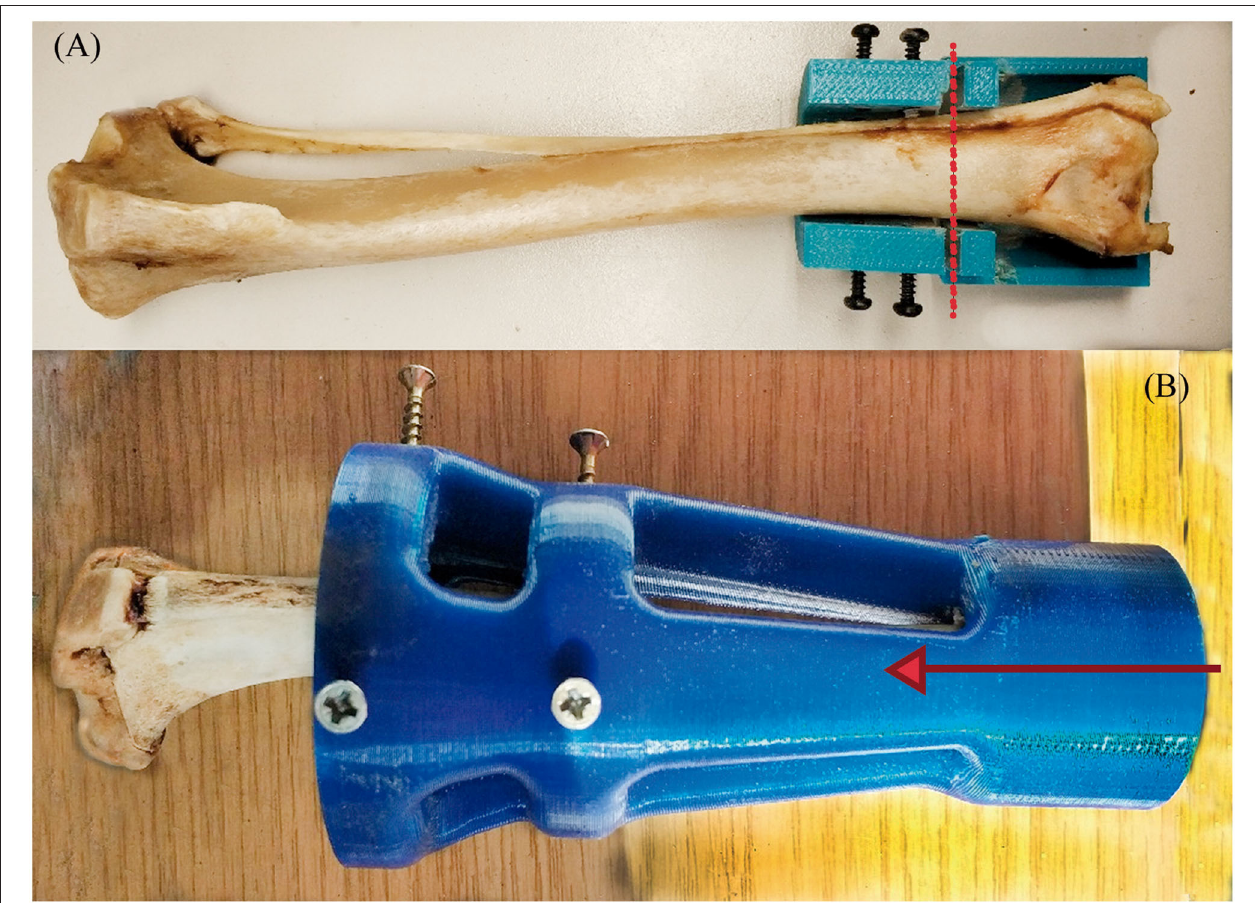
FIGURE 3 | Transverse cut (A) and MC-concentric drill (B) guides. Both self-designed and printed at PLA. At (A) , the red dash line represents where the transversal cut was made on the distal tibia. At (B) , the red arrow represents the drilling direction of the MC to homogenize the MC diameter.